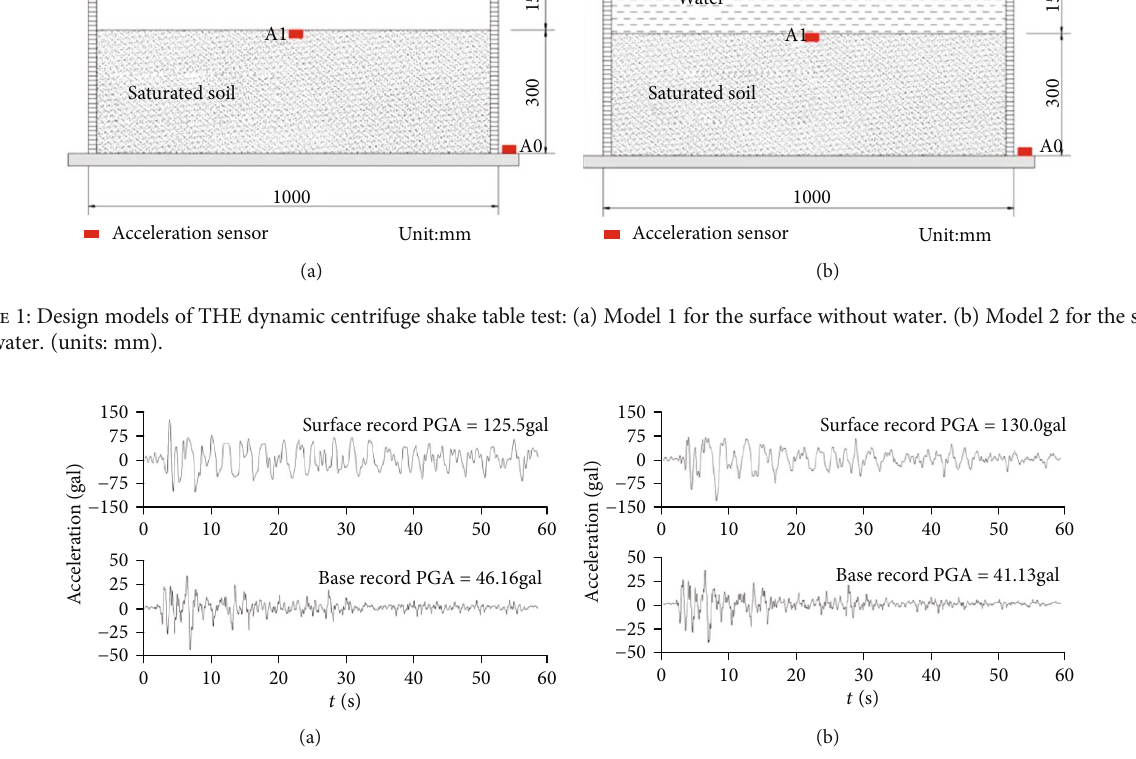
Figure 2: Acceleration time history response of EL – 1 situation: (a) model 1 and (b) model 2.